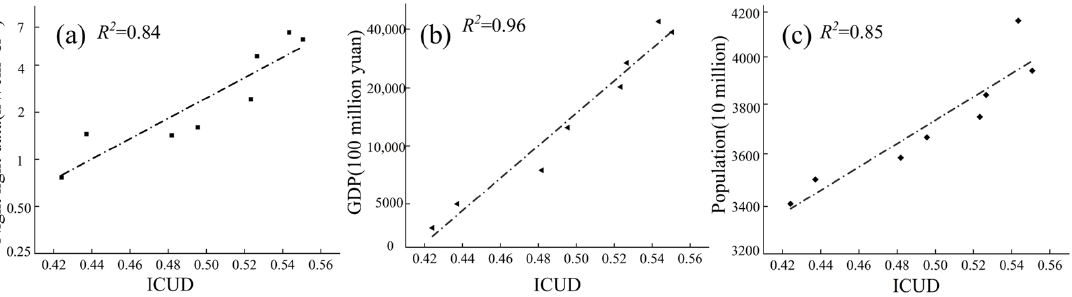
Figure 7. The relationship between ICUD and ( a ) night light data; ( b ) GDP; ( c ) population at the provincial level.